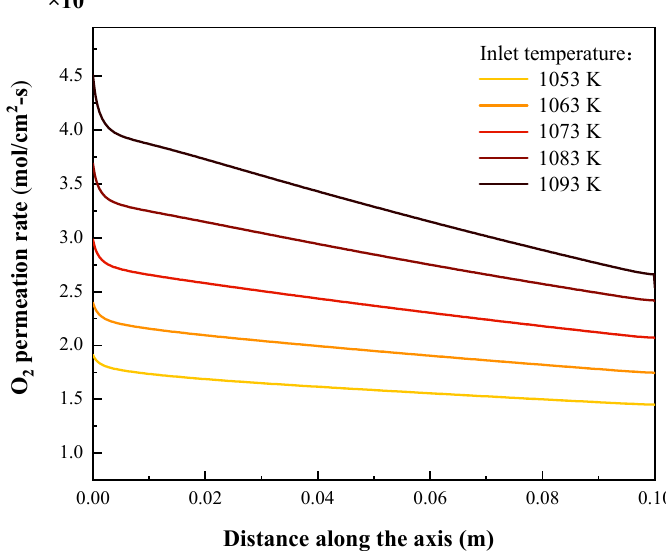
Figure 14. Effect of inlet temperature on oxygen permeation rate.